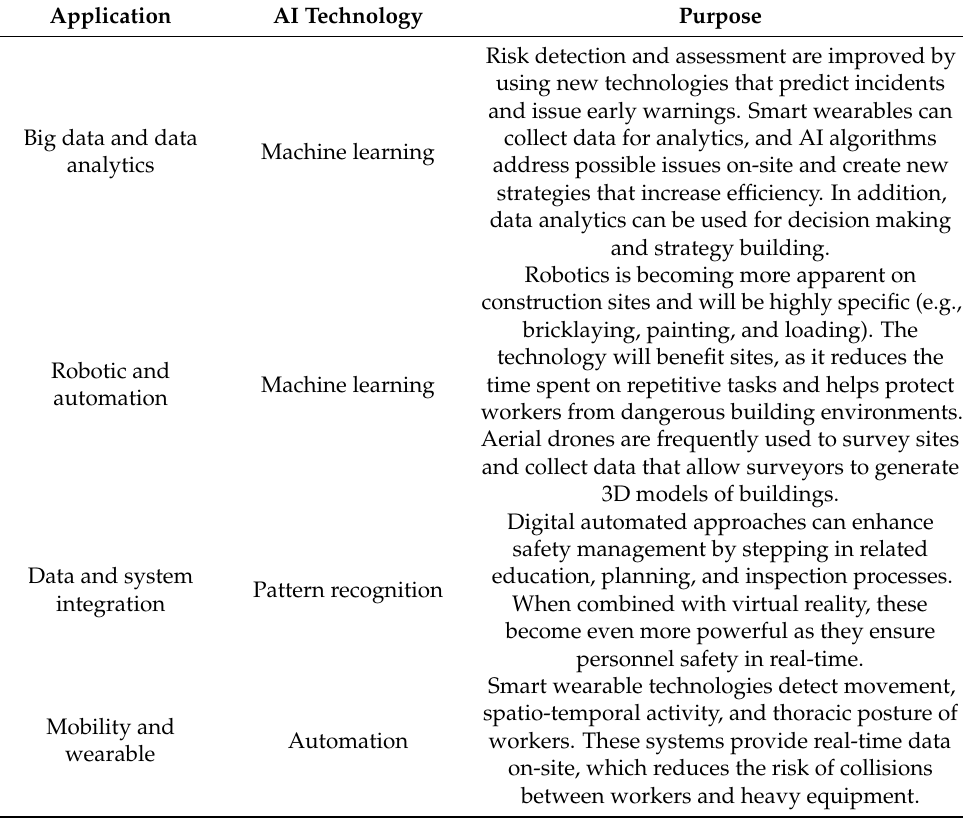
Table 1. Common AI technologies used in the construction industry, derived from